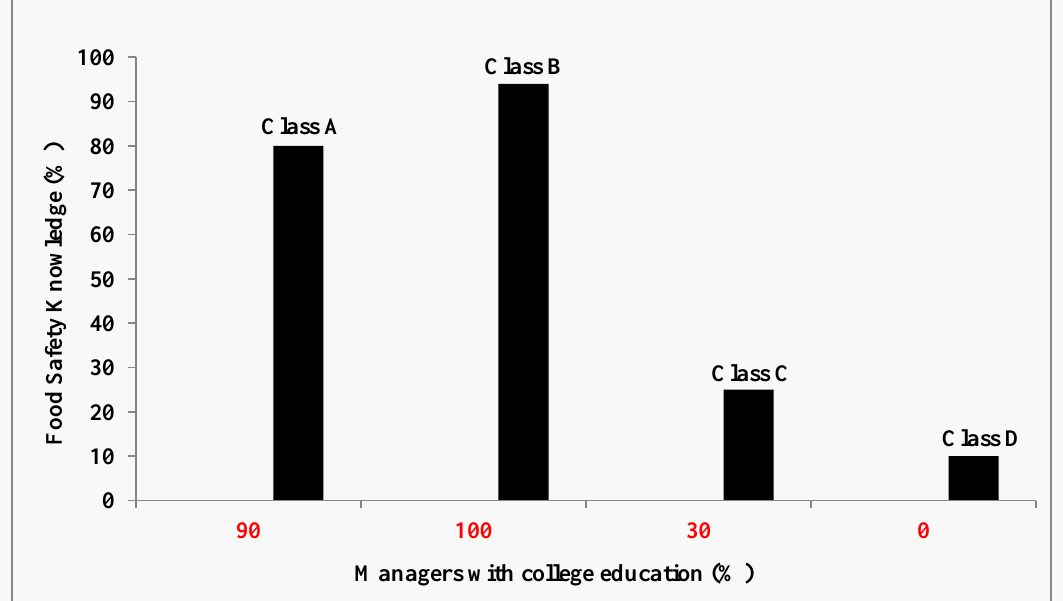
Figure 5. Relationship between managers’s education, restaurant class and food safety